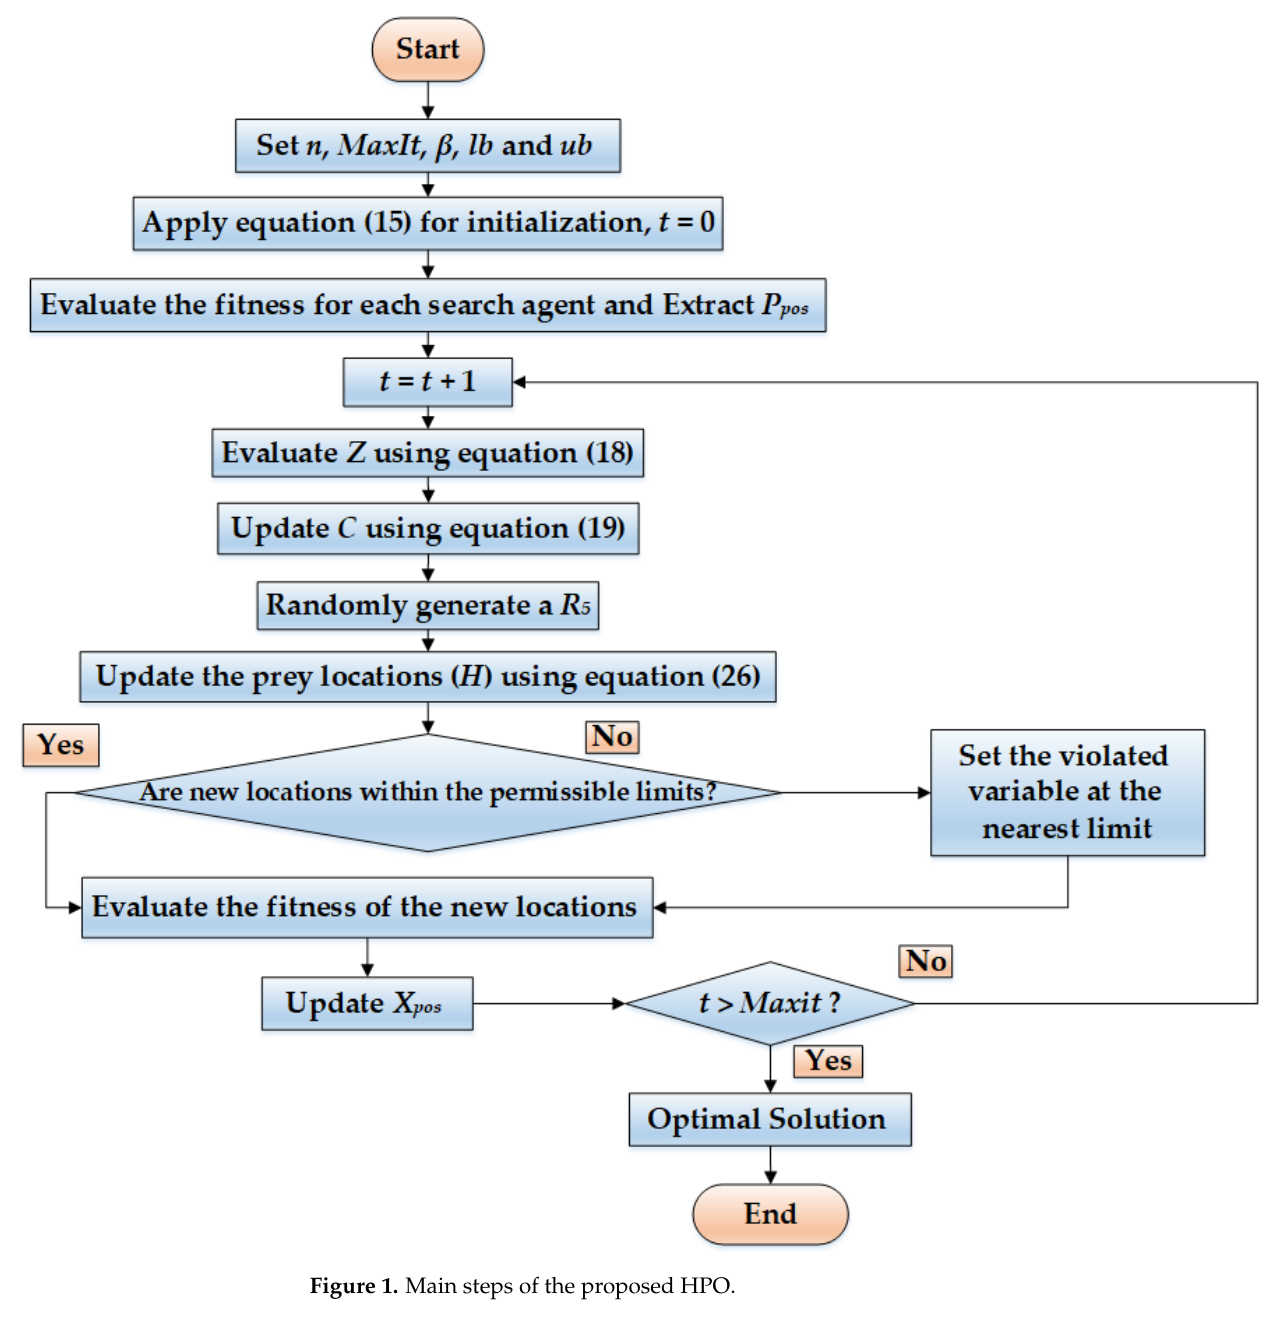
Figure 1. Main steps of the proposed HPO.